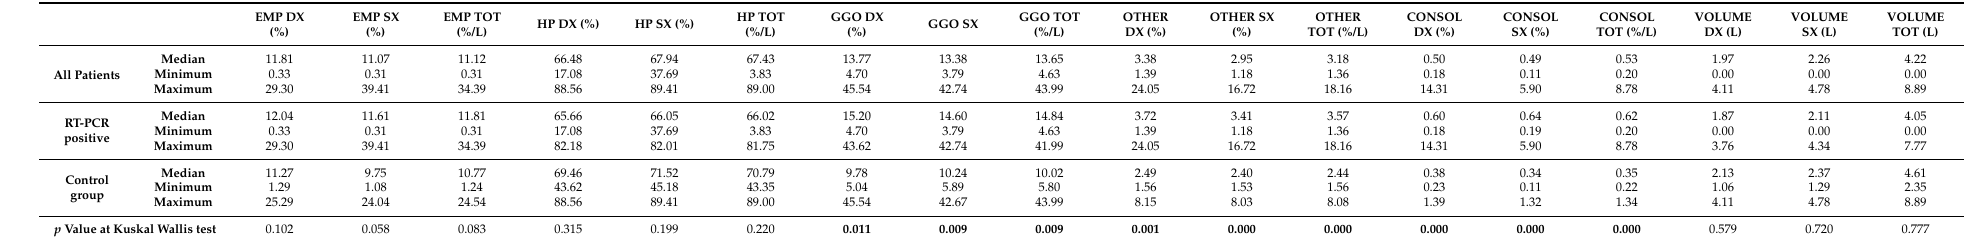
Table 6. Lung volumes quantified using the ANKE ASG-340 CT workstation pneumonia tool in terms of median, minimum, and maximum values obtained on baseline CT scans.